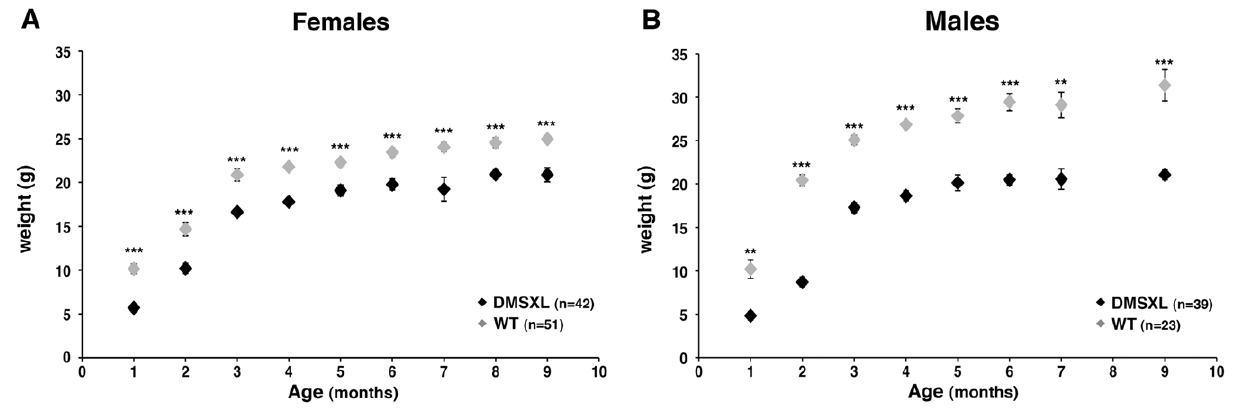
Figure 7. Weight monitoring and follow-up with age. Weight (in grams, g) was recorded for female (A) and male (B) DMSXL homozygotes ( + / + ) and WT littermate controls (WT). Differences in body weight between DMSXL and WT mice were determined to be statistically significant by Student’s t test, ** p , 0.01, *** p , 0.001.